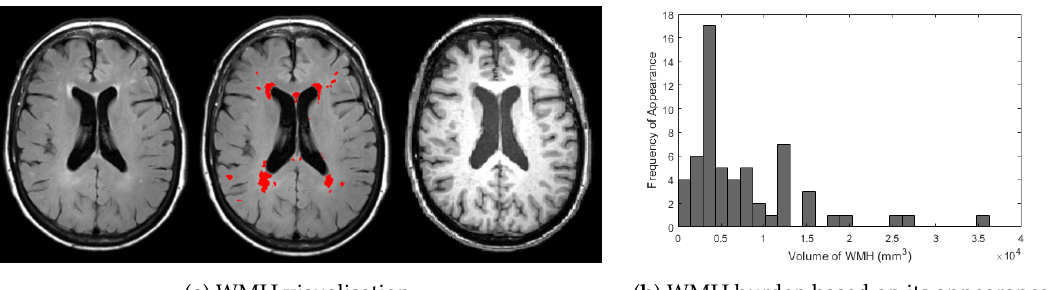
Figure 1. ( a ) Visualisation of WMH in T2-FLAIR ( left ) and T1-weighted ( right ) of MRI and ( b ) histogram frequency of appearance based on WMH burden from ADNI dataset used in this study. In ( a ) above, bright regions of WMH are overlaid by red masks marked by clinical observer ( centre ). Whereas, histogram in ( b ) were produced by calculating WMH volume for all 60 MRI data from ADNI dataset used in this